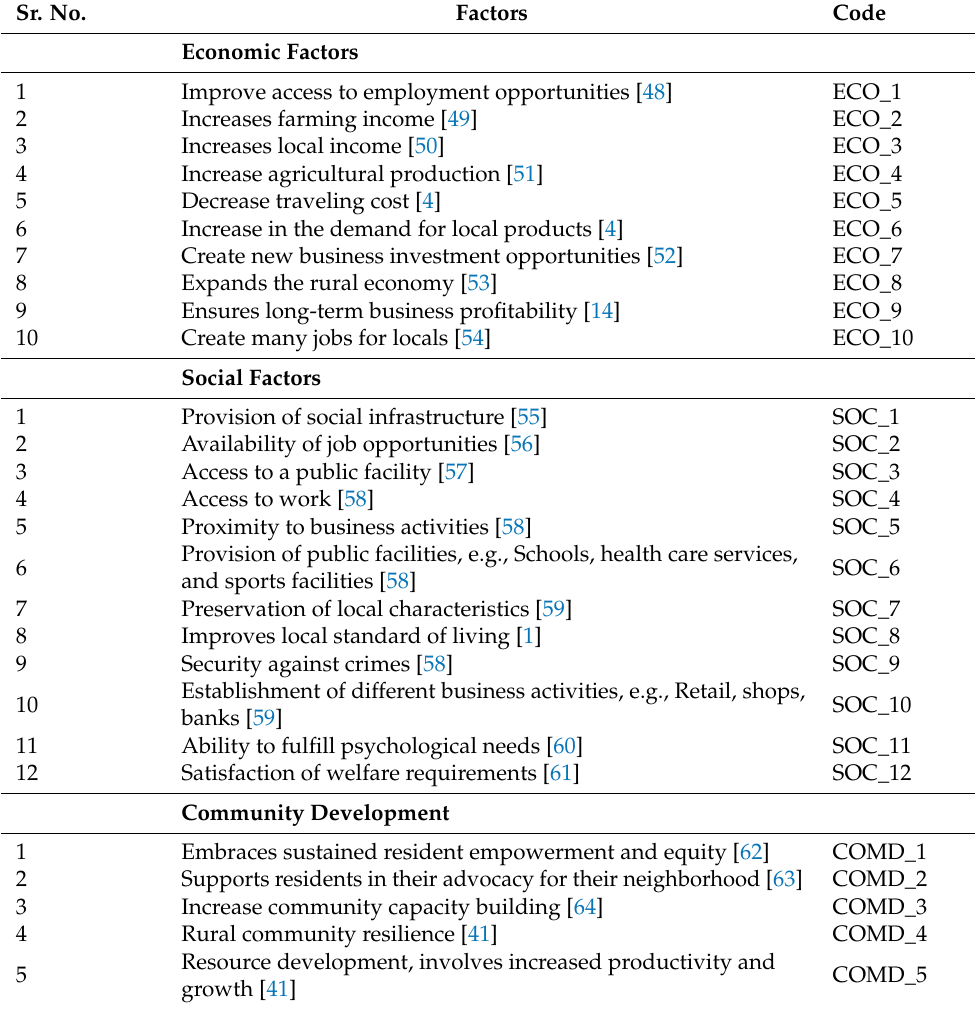
Table 1. Socio-economic development factors and community development factors. Sr.